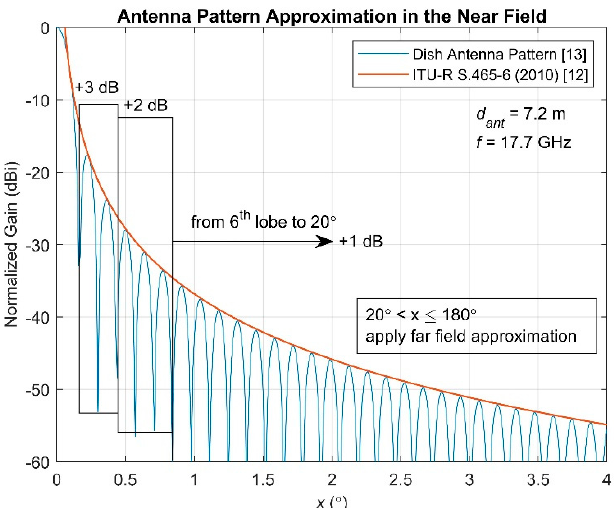
Figure 3. Antennae gain approximations with respect to the off bore-sight angle, taking into consid- eration the near field.